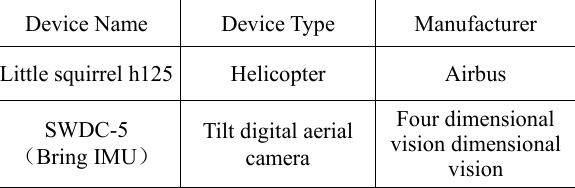
Table 1. Parameter table of tilt photography instrument